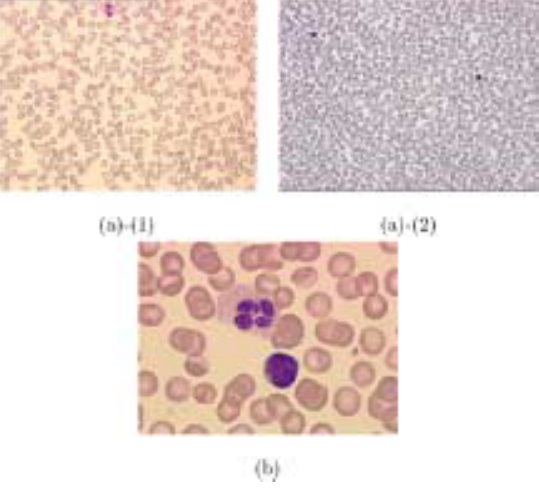
Fig. 1. Peripheral blood smear stains with May-Grünwald Giemsa: (a) Low magnifying power, (1) immersion objective × 25 and (2) im- mersion objective × 16. (b) High magnifying power, immersion ob- jective × 100. This figure can be viewed on http://www.esacp.org